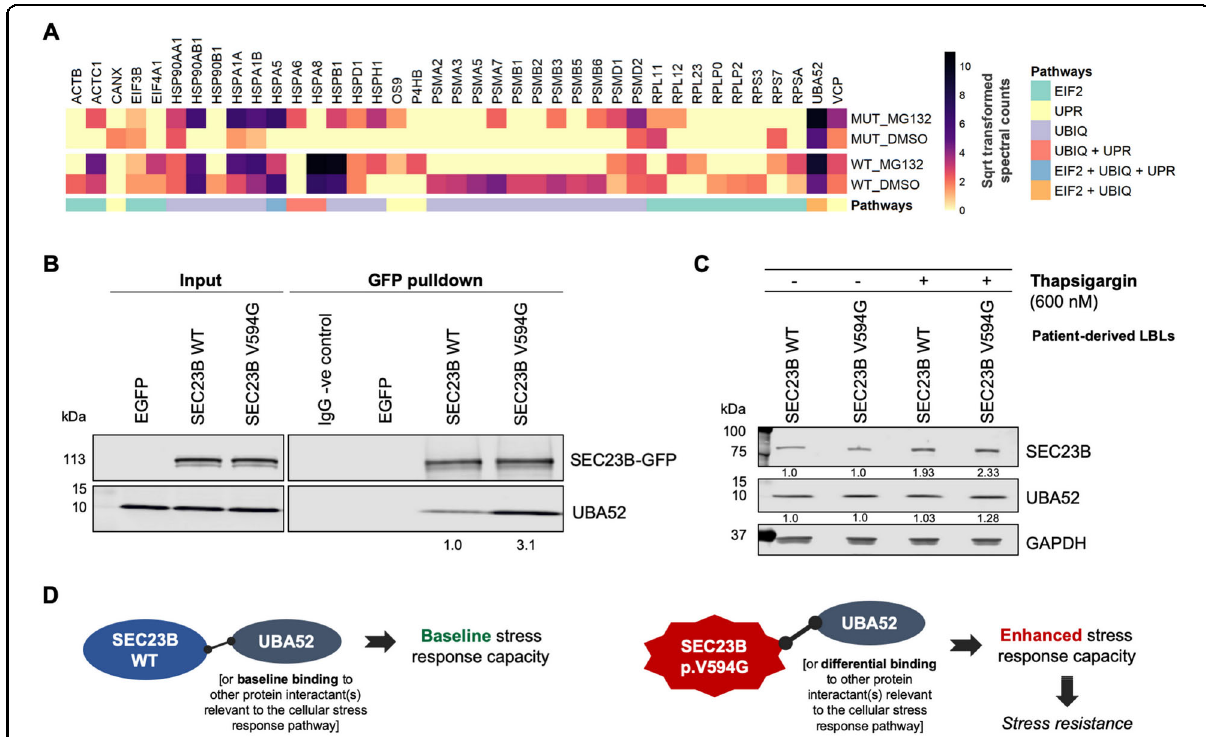
Fig. 5 SEC23B interacts with proteins related to the cellular stress response pathway. A Pathway analysis of SEC23B-interacting proteins in Nthy- SEC23B -WT and Nthy- SEC23B -V594G cells with and without MG132 treatment. EIF2 eukaryotic initiation factor 2 signalling, UPR unfolded protein response, UBIQ protein ubiquitination pathway, Sqrt square root, MUT SEC23B -V594G. B Validation of the SEC23B – UBA52 interaction using immunoprecipitation of EGFP-tagged SEC23B in Nthy- SEC23B -WT and Nthy- SEC23B -V594G cells followed by immunoblotting using the UBA52 antibody. Nthy-EGFP cell line and normal rabbit IgG are used as negative controls. UBA52 protein levels are normalized to SEC23B-EGFP pulldown within each genotype and quanti fi cation values are relative to wild-type. Mutant SEC23B shows increased binding to UBA52. C SEC23B and UBA52 protein levels in patient-derived SEC23B wild-type and p.Val594Gly mutant lymphoblastoid cell line (LBL) pools with and without treatment with the ER stress-inducing agent Thapsigargin (600 nM, 5 days). Each genotypic group includes 5 LBLs with either wild-type or p.V594G mutant SEC23B, respectively (see “ Materials and methods ” ). D Proposed model of how SEC23B, irrespective of mutation status, could be playing multiple unexplored roles in the cellular stress response pathway. SEC23B – UBA52 cross-talk represents one proof-of-principle